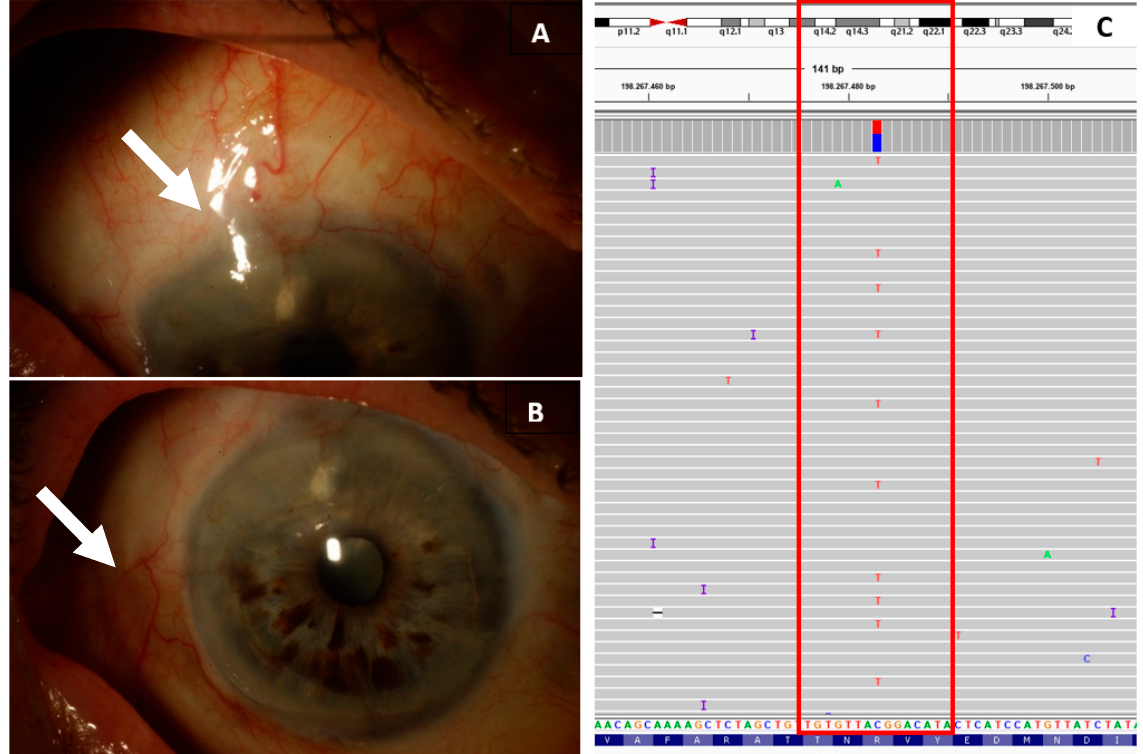
Figure 1. Clinical pictures and molecular data concerning the conjunctival melanoma harboring a SF3B1 mutation. In ( A ) the macroscopic view of the melanoma located on the bulbar conjunctiva, within ( B ) the primary acquired melanomsis with atypia component (white arrow). Depicted in the red box in ( C ) is the molecular data concerning a p.Arg625His mutation in SF3B1 , with an allele frequency of 42%, using the Integrative Genomics Viewer.